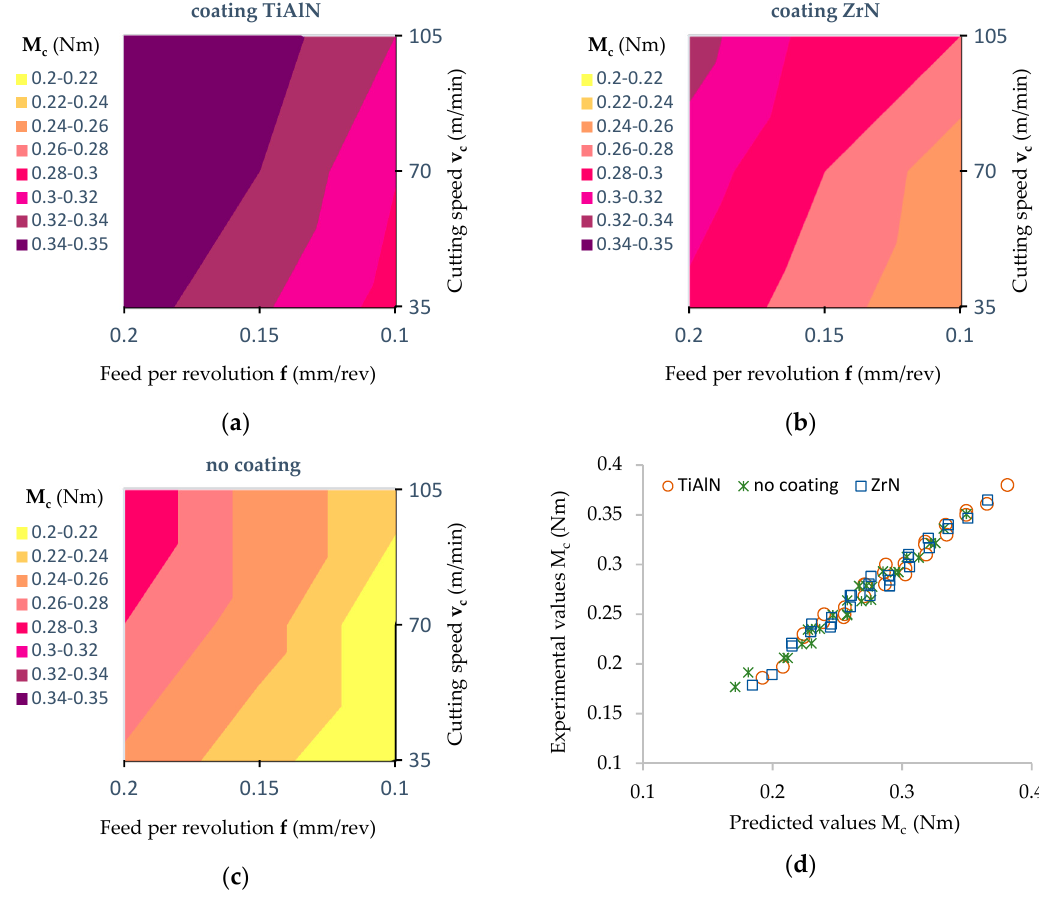
Table 5. Significance level of the effect of cutting parameters on the average cutting torque (M c ). Tests Applied